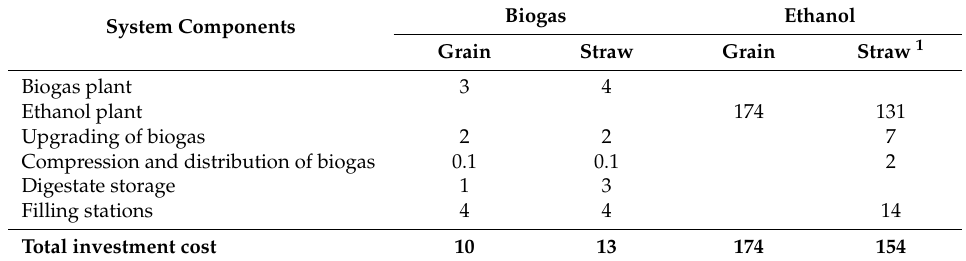
Table A12. Investment costs (million € ) for biogas and ethanol production plants using wheat grain and straw, respectively [22,26,27].